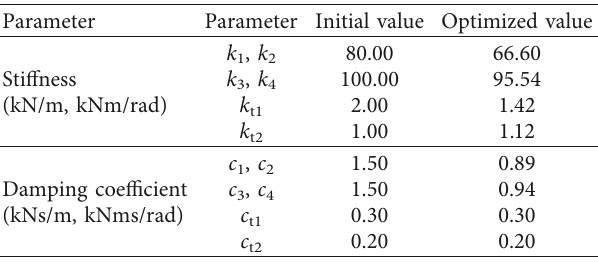
Figure 3: Mode shapes of the five-degree-of-freedom human model (solid line: initial configuration; dashed line: mode shape configuration; black color: head; blue color: trunk; red color: lower body). Table 3: Initial and optimized values of the stiffness and damping coefficients.